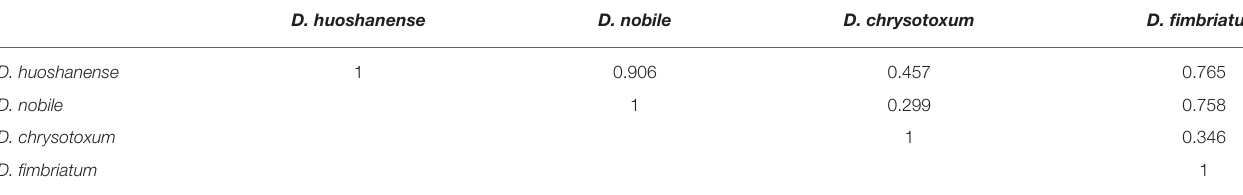
TABLE 6 | Correlation coefficients based on the contents of compounds 1–11 in the four Dendrobium species used for preparing